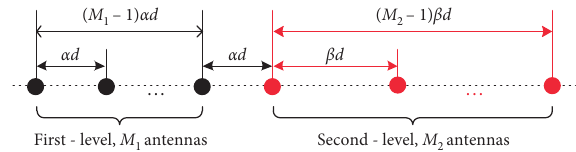
Figure 1: Yang-NA